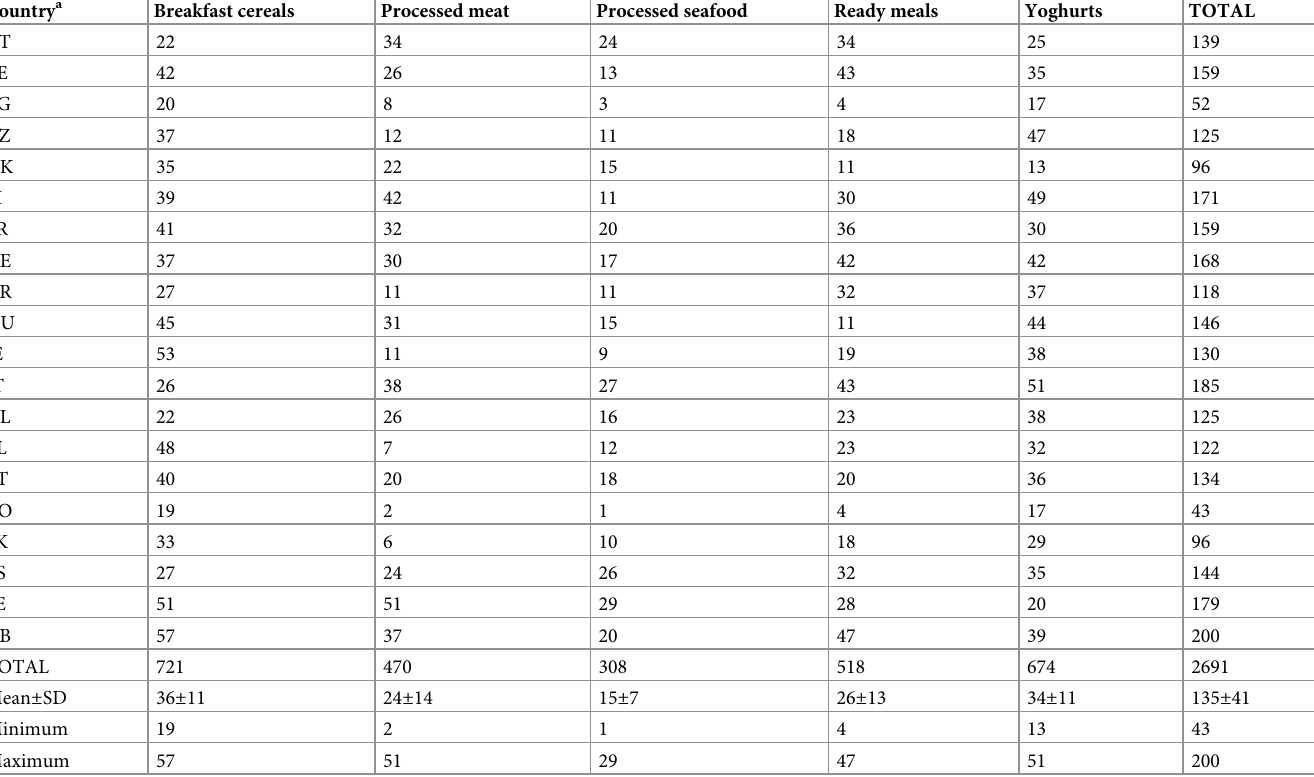
Table 2. Number of products from the Euromonitor Nutrition 2016 database with complete nutrition criteria information and non-zero brand share by category and country. Country a Breakfast